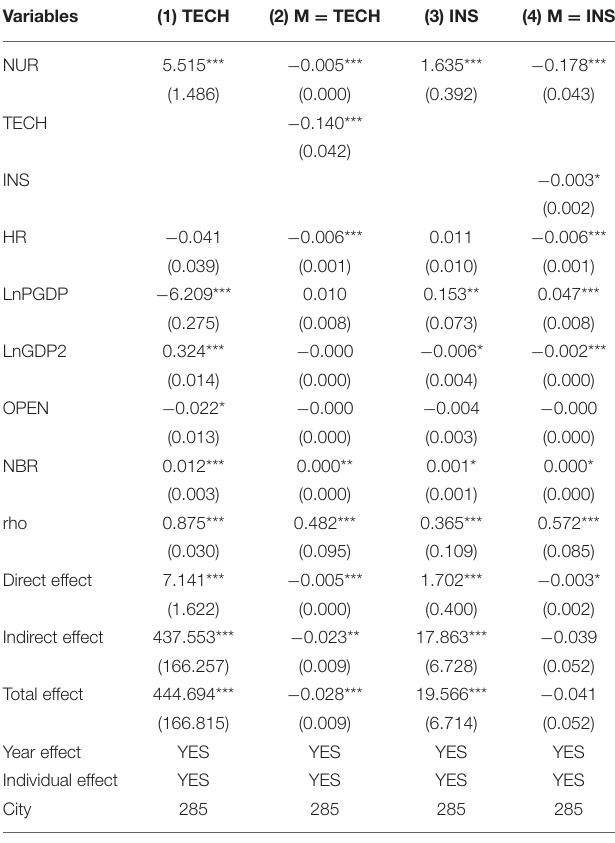
TABLE 10 | Mediating effect.